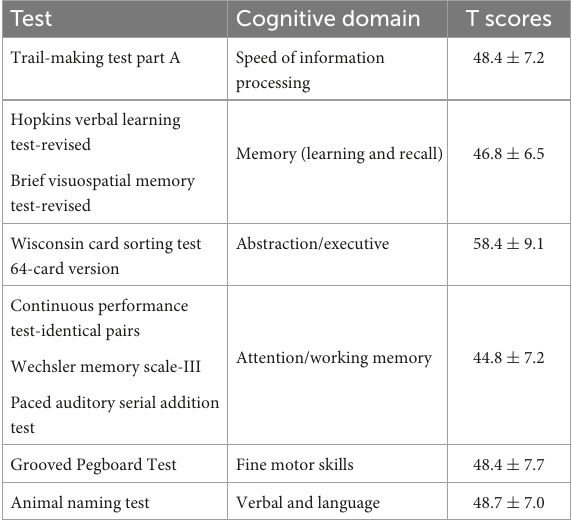
TABLE 2 Applied neurocognitive test battery and neurocognitive performance in